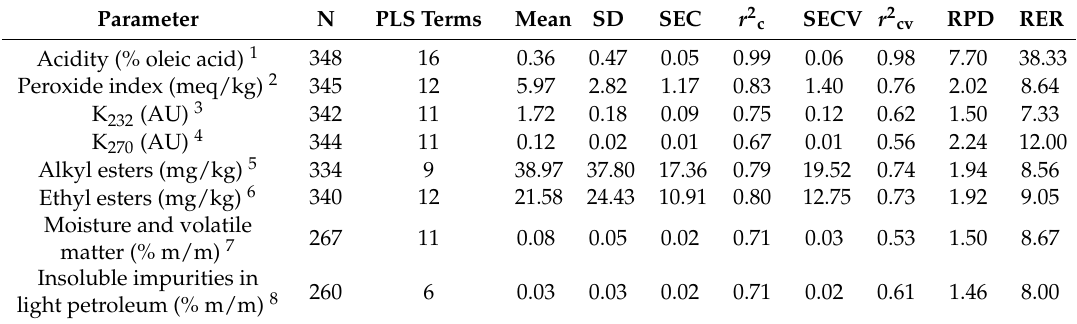
Table 3. Calibration statistics for the best models for predicting quality parameters in olive oil. FNS-6500 SY-I monochromator with dynamic (spinning module) sample